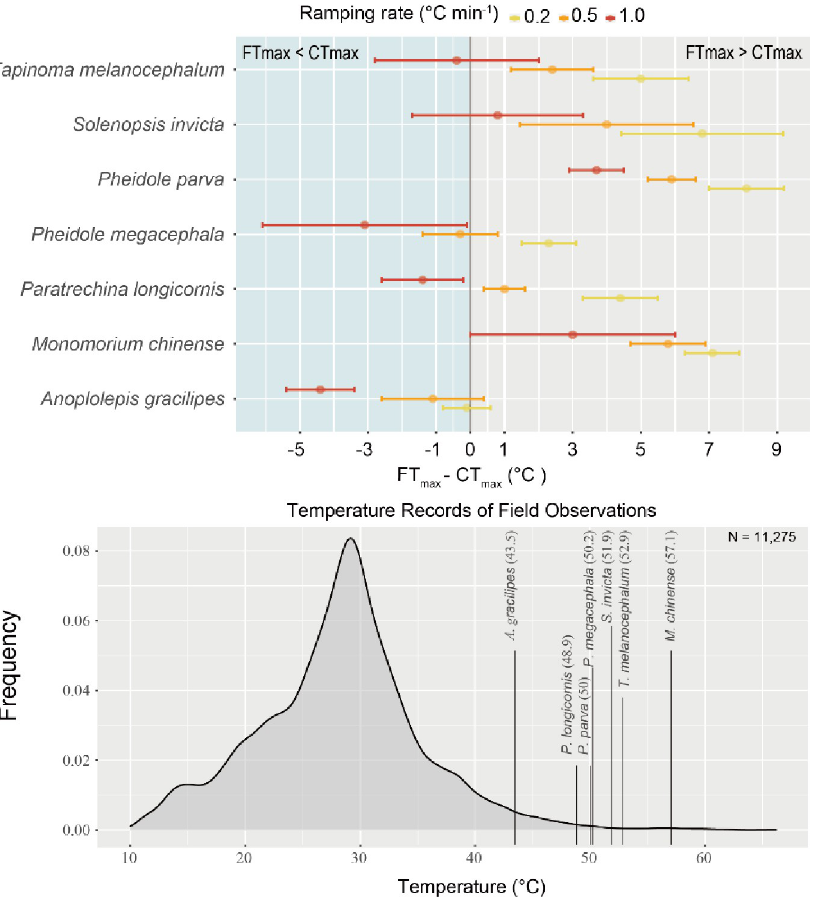
Fig 4. Critical Thermal maximum vs. foraging temperature records. Upper plot showing the difference between FT max and CT max (0.2, 0.5, and 1.0) and errors bars as standard deviation of the CT max values. Lower plot shows the range and distribution frequency of all surface temperatures measured near baiting stations during the sampling period, independently of the presence of ants or not. Vertical lines indicate the FT max values measured for each species in the field.